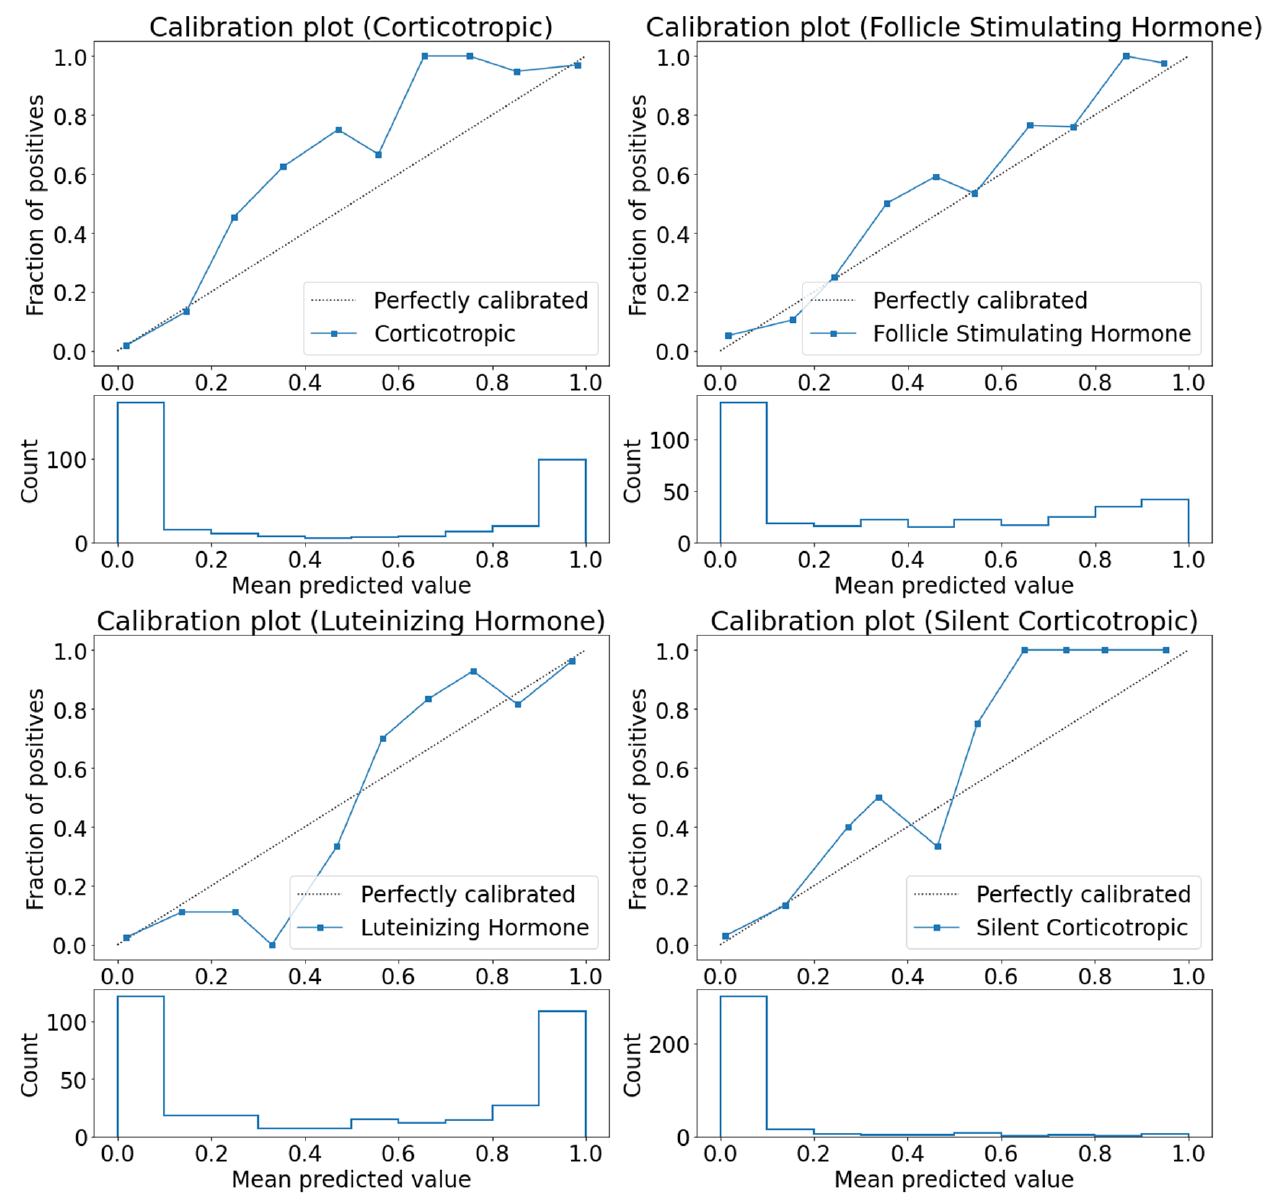
Figure 12. Results | Calibration plot . Figure 12. Results|Calibration